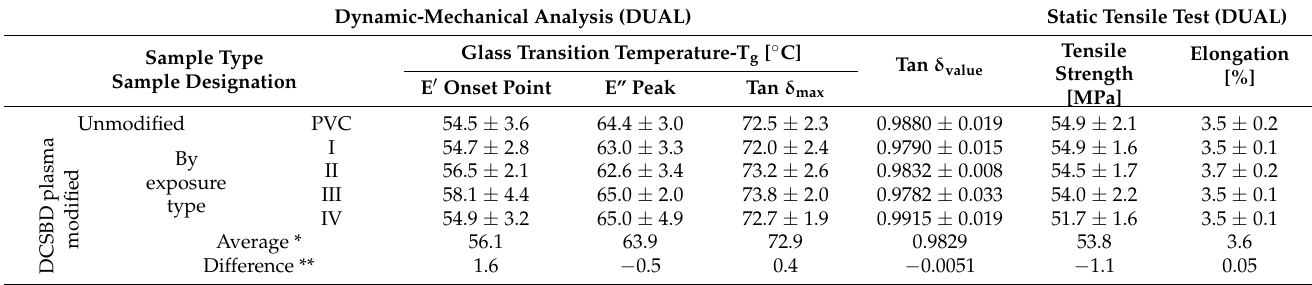
Table 4. Tensile test results: dynamic-mechanical analysis (glass transition temperatures) with Tan δ values and static tensile test (Tensile strength and